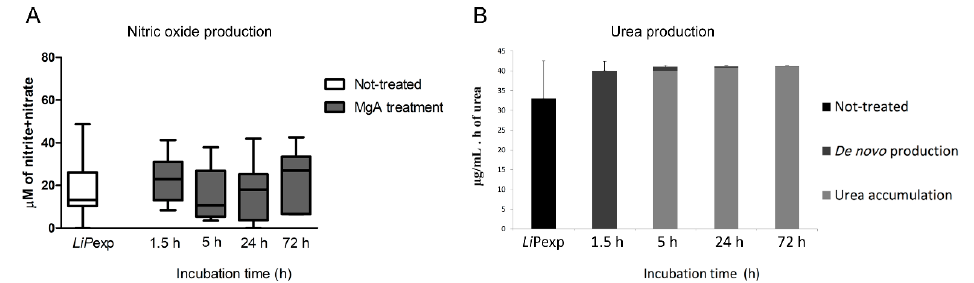
Figure 6. Nitric oxide and urea production by L. infantum exposed spheroids treated with meglumine antimoniate (MgA). Hepatic spheroids exposed to L. infantum promastigotes for 72 h were treated with MgA. At different time points, samples of culture medium were analysed for nitric oxide (NO) ( A ) and urea production ( B ). Untreated hepatocyte aggregates exposed to parasites for 72 h ( Li Pexp) were also used to evaluate NO. Results of samples of 10 dogs performed in triplicate are represented by box plots, whiskers (minimum to maximum), and median in the case of NO, and by the mean and standard error in the case of urea.